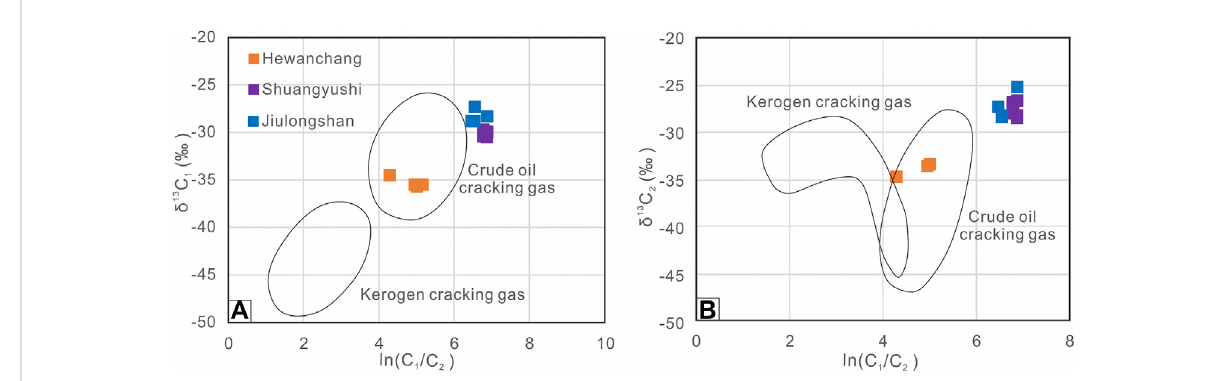
FIGURE 5 Cross-plots of ln (C 1 /C 2 ) vs. δ 13 C 1 (A) and ln (C 1 /C 2 ) vs. δ 13 C 2 (B) for natural gas samples from different areas to indicate the genetic types of natural gas. The distribution ranges of different genetic types of natural gas are referred to Liu et al. (2018).